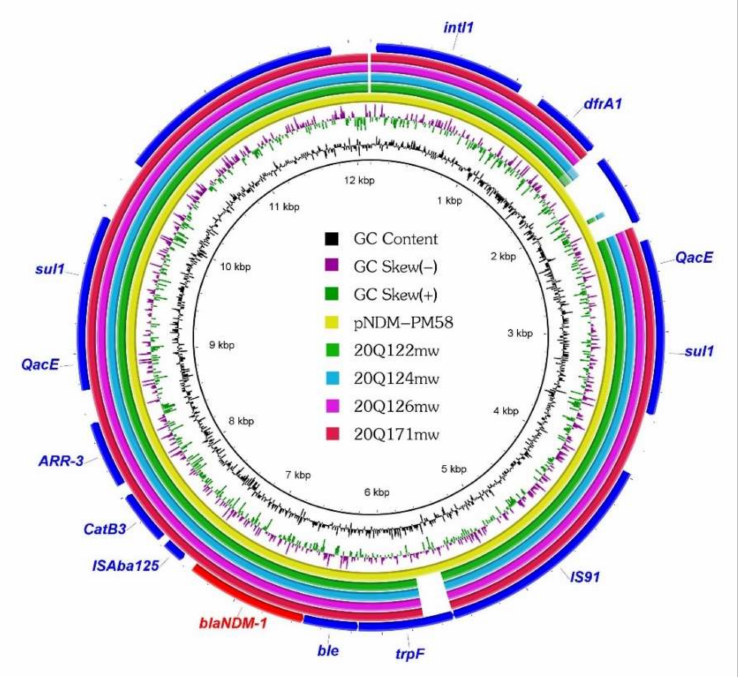
Figure 2. Comparison of the whole-genome sequences of Providencia spp. strains with the sequence of plasmid pNDM-PM58 (GenBank accession number